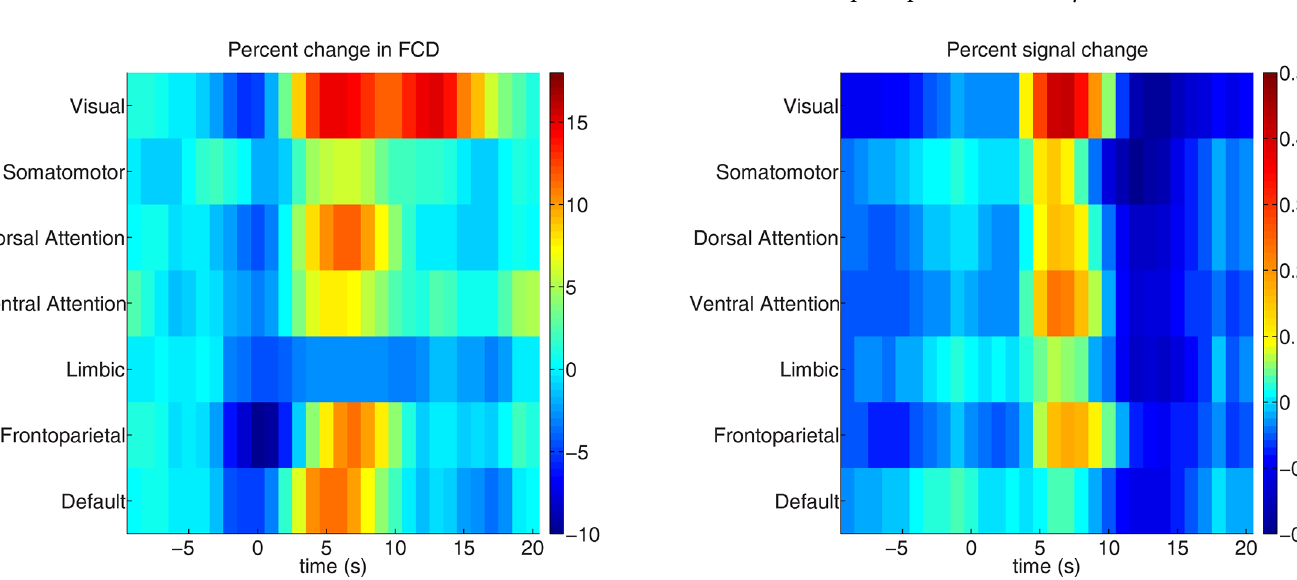
PLOS ONE | https://doi.org/10.1371/journal.pone.0190480 January 22,